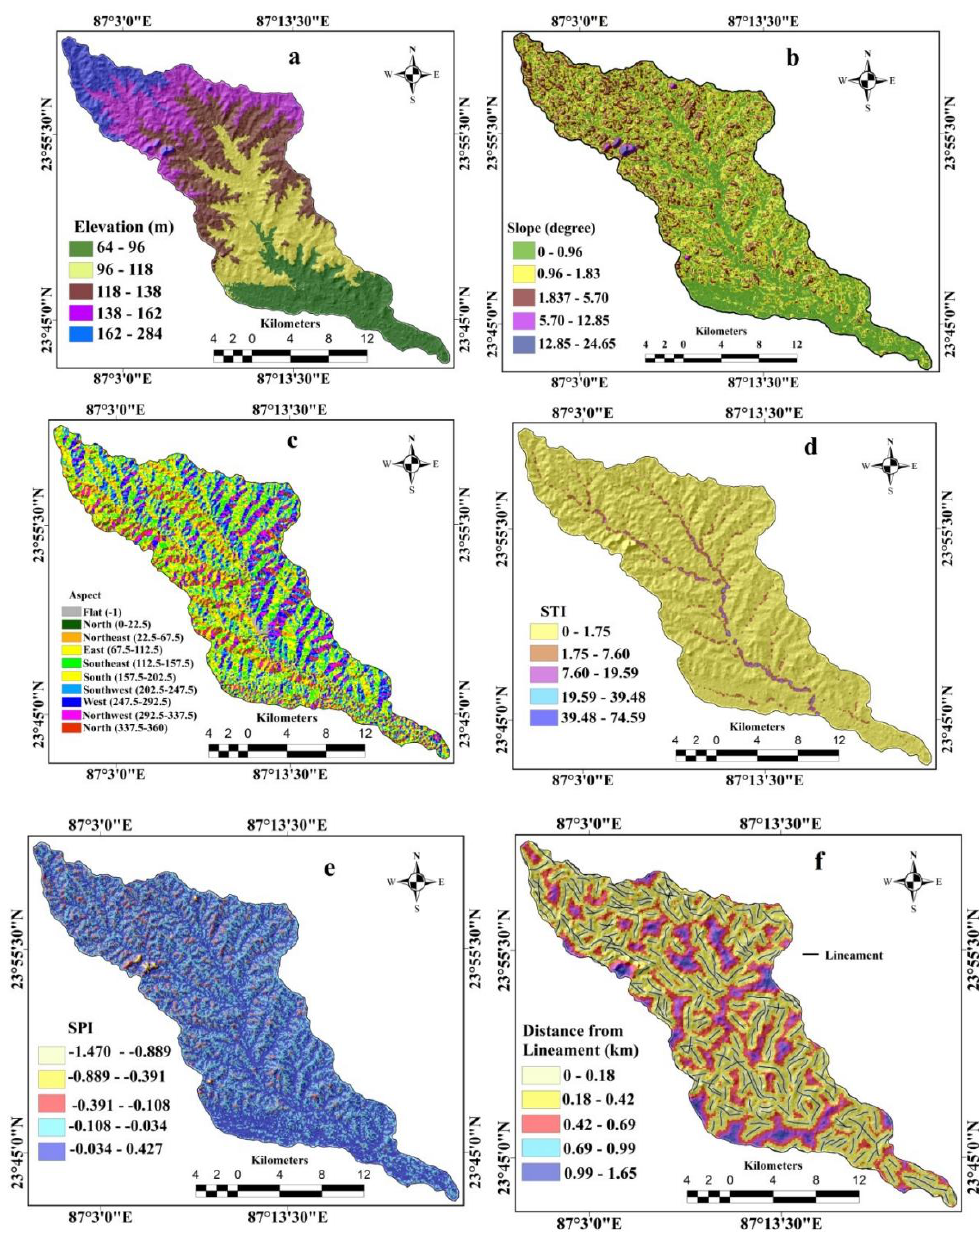
Figure 4. The topographical factors: ( a ) elevation, ( b ) slope, ( c ) aspect, ( d ) sediment transportation index (STI), ( e ) stream power index (SPI), ( f ) distance from lineament.